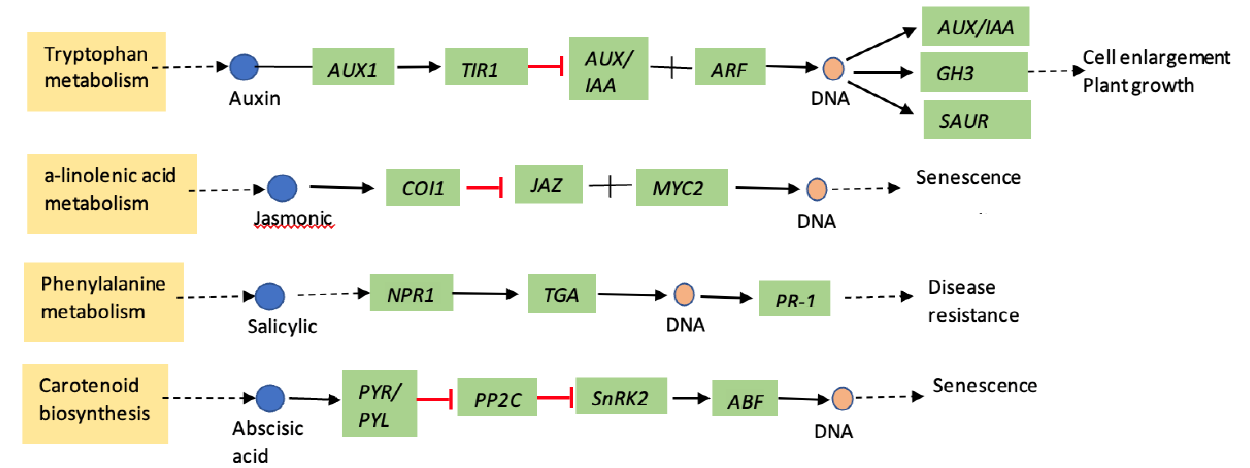
Figure 1. Schematic diagram of major plant hormone signal transduction pathway for sorghum (adapted from KEGG, yellow highlights are pathway name, dotted arrow represents multiple enzymatic steps, green highlights are genes in respective pathways). AUX—auxin influx carrier; TIR1—transport inhibitor response1; AUX/IAA—auxin/indole-3-acetic acid; ARF—auxin response factor; GH3—auxin responsive Gretchen hagen3; SAUR—small auxin upregulated RNA; COI1—coronatine-insensitive protein 1; JAZ—jasmonate ZIM-domain; MYC2—transcription factor MYC2; NPR1—regulatory protein NPR1; TGA—transcription factor TGA; PR-1—pathogenesis related-1; PYR/PYL—abscisic acid receptor PYR/PYL family; PP2C—protein phosophatase 2C; snRK2—serine/threonine-protein kinase; ABF—ABA responsive element biding factor.